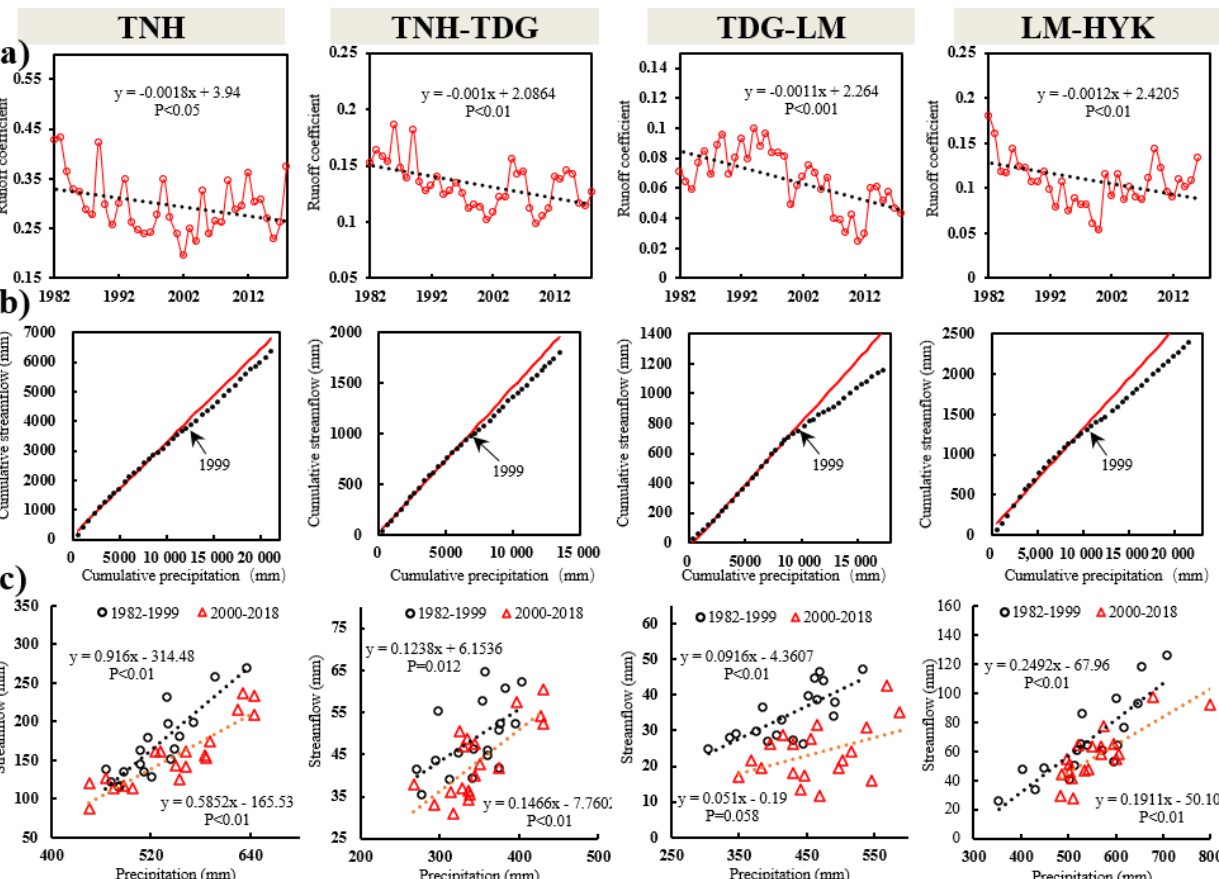
Figure 7. (a) The interannual change trend of annual runoff coefficients for different subregions, (b) precipitation–streamflow double mass curves for the four subregions, and (c) precipitation–streamflow relationships in the two periods of 1982–1999 and 2000–2018 for the four subregions. Table 4. Model performance metrics of monthly streamflows and seasonal cycles of streamflows in different drainage areas.